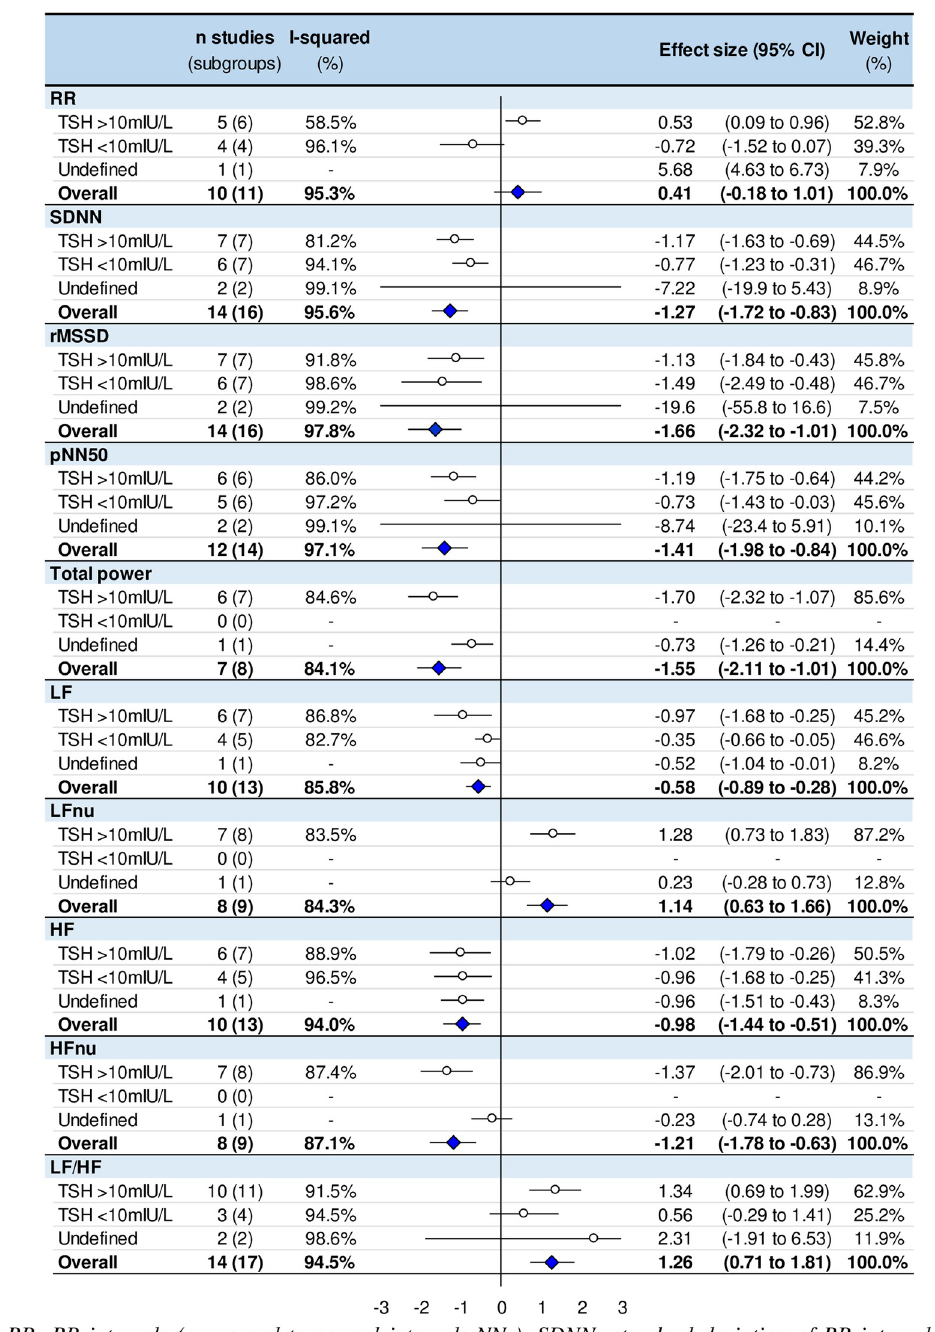
Fig 2. Meta-analysis of heart rate variability parameters of untreated hypothyroid patients compared with controls.